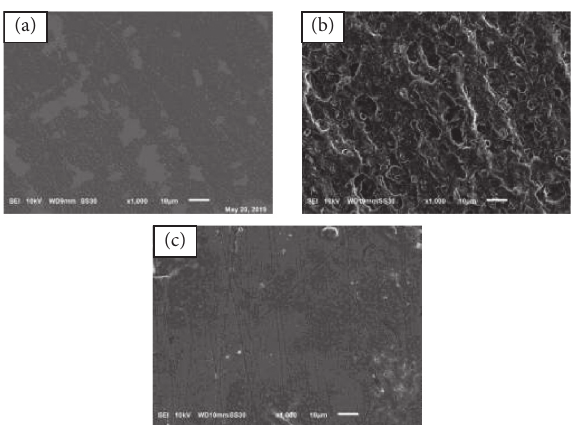
Figure 13: SEM images of low carbon steel surfaces (a) before corrosion, (b) in 1.0M HCl, and (c) in 2.10 − 4 M BPTU.